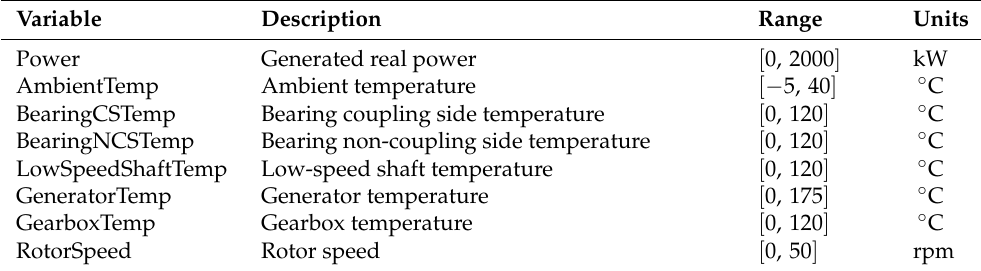
Table 3. Selected SCADA variables to develop the normal behavior model, its description, range of possible values, and units. All of them are related to the mean value over a 10-min period. Variable Description Range Units Power Generated real power [ 0, 2000 ] kW AmbientTemp Ambient